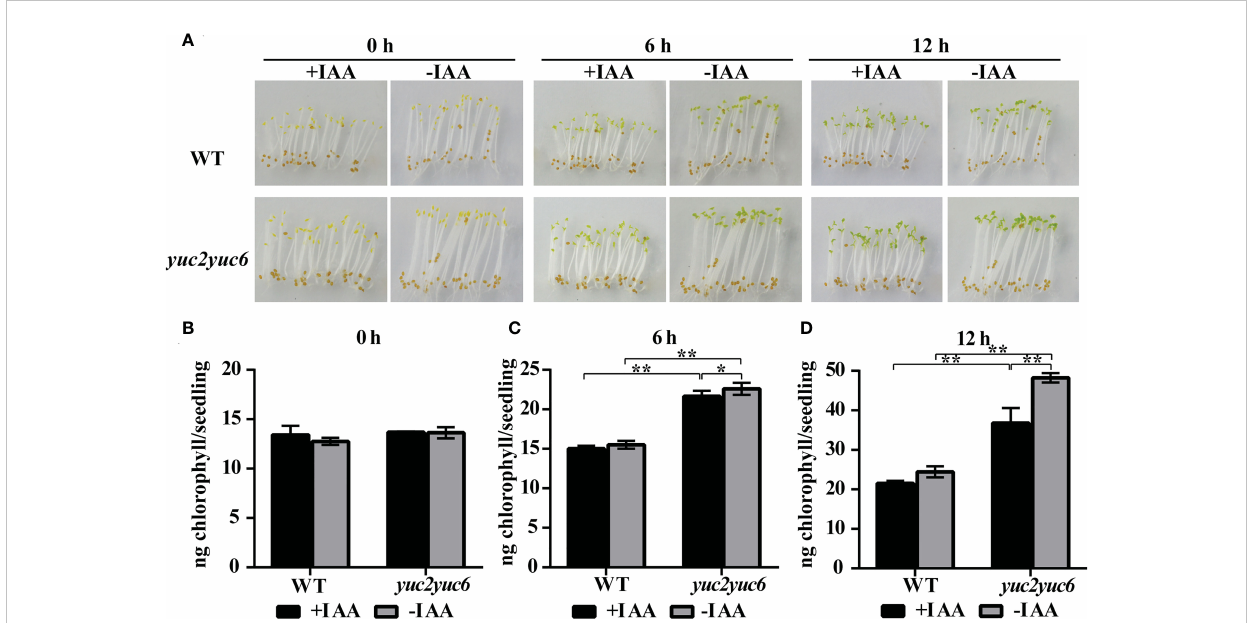
FIGURE 4 Auxin inhibits chlorophyll accumulation during de-etiolation. (A) Etiolated seedlings exposed to light under IAA treatment. (B-D) Chlorophyll content at each time point during de-etiolation. ‘ +IAA ’ represents seedlings treated with 1 m M IAA, ‘ -IAA ’ represents seedlings within no IAA treatment, * represents p value <0.05, ** represents p value